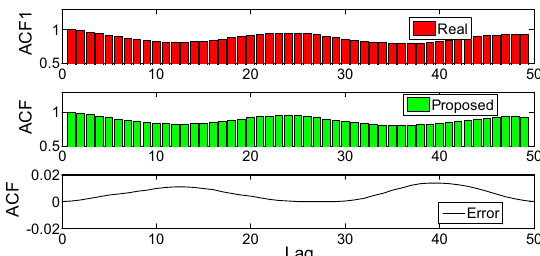
Fig. 4 Sample autocorrelation functions